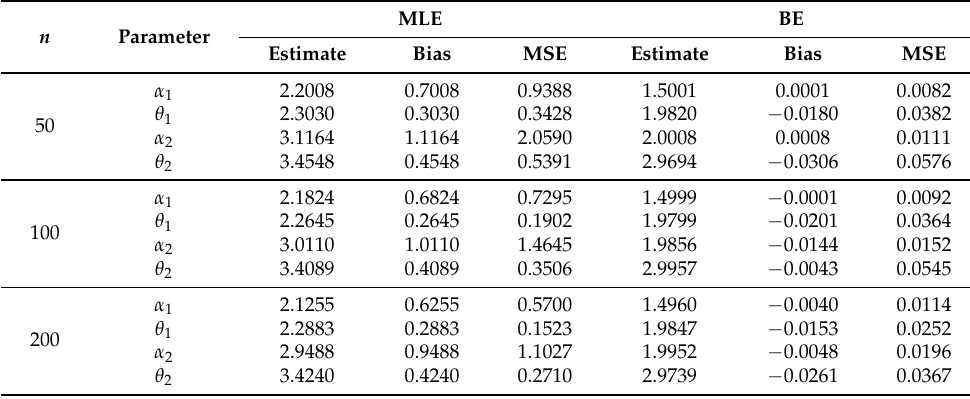
Table 1. Point estimates of ( α t , θ t ) , t = 1,2 under Scheme 1.